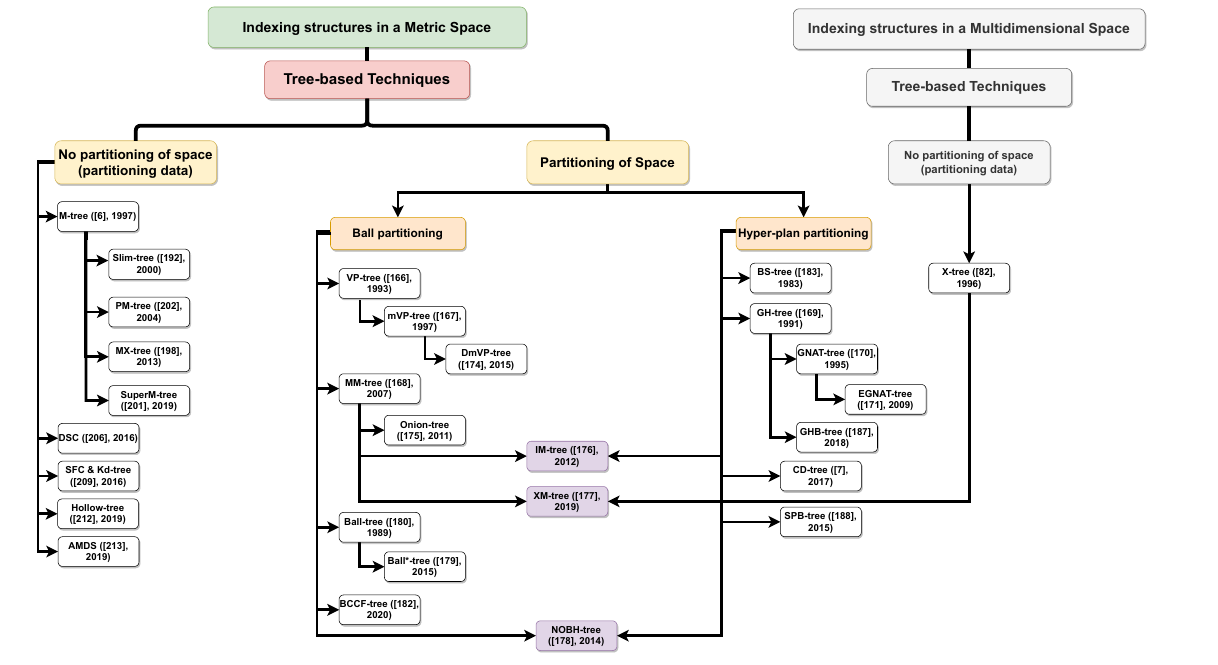
Figure 9. Taxonomy of tree-based indexing techniques in metric